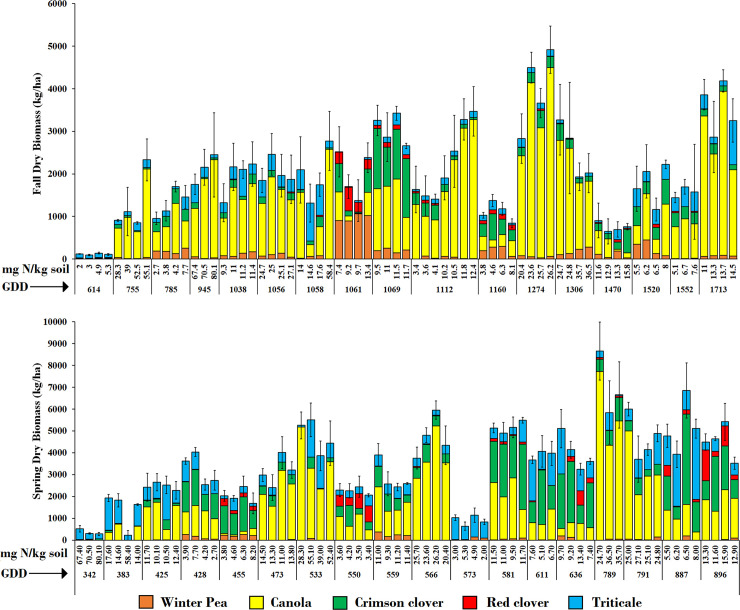
Standard mixture fall and spring biomass.Standard mixture dry biomass (kg ha-1) of each cover crop species in the fall (top) and spring (bottom) at the on-farm sites in two years, as affected by N availability (mg N kg-1 soil) and fall GDD (from planting to 31 December, top) and spring GDD (from 1 January to termination, bottom). The same mixture was planted at all locations. Each bar represents biomass expression in each of the four replicates of each site, and bars are sorted by increasing GDD and soil iN. Standard Errors for the total biomass are also included. Note that scales for the fall and spring are different.